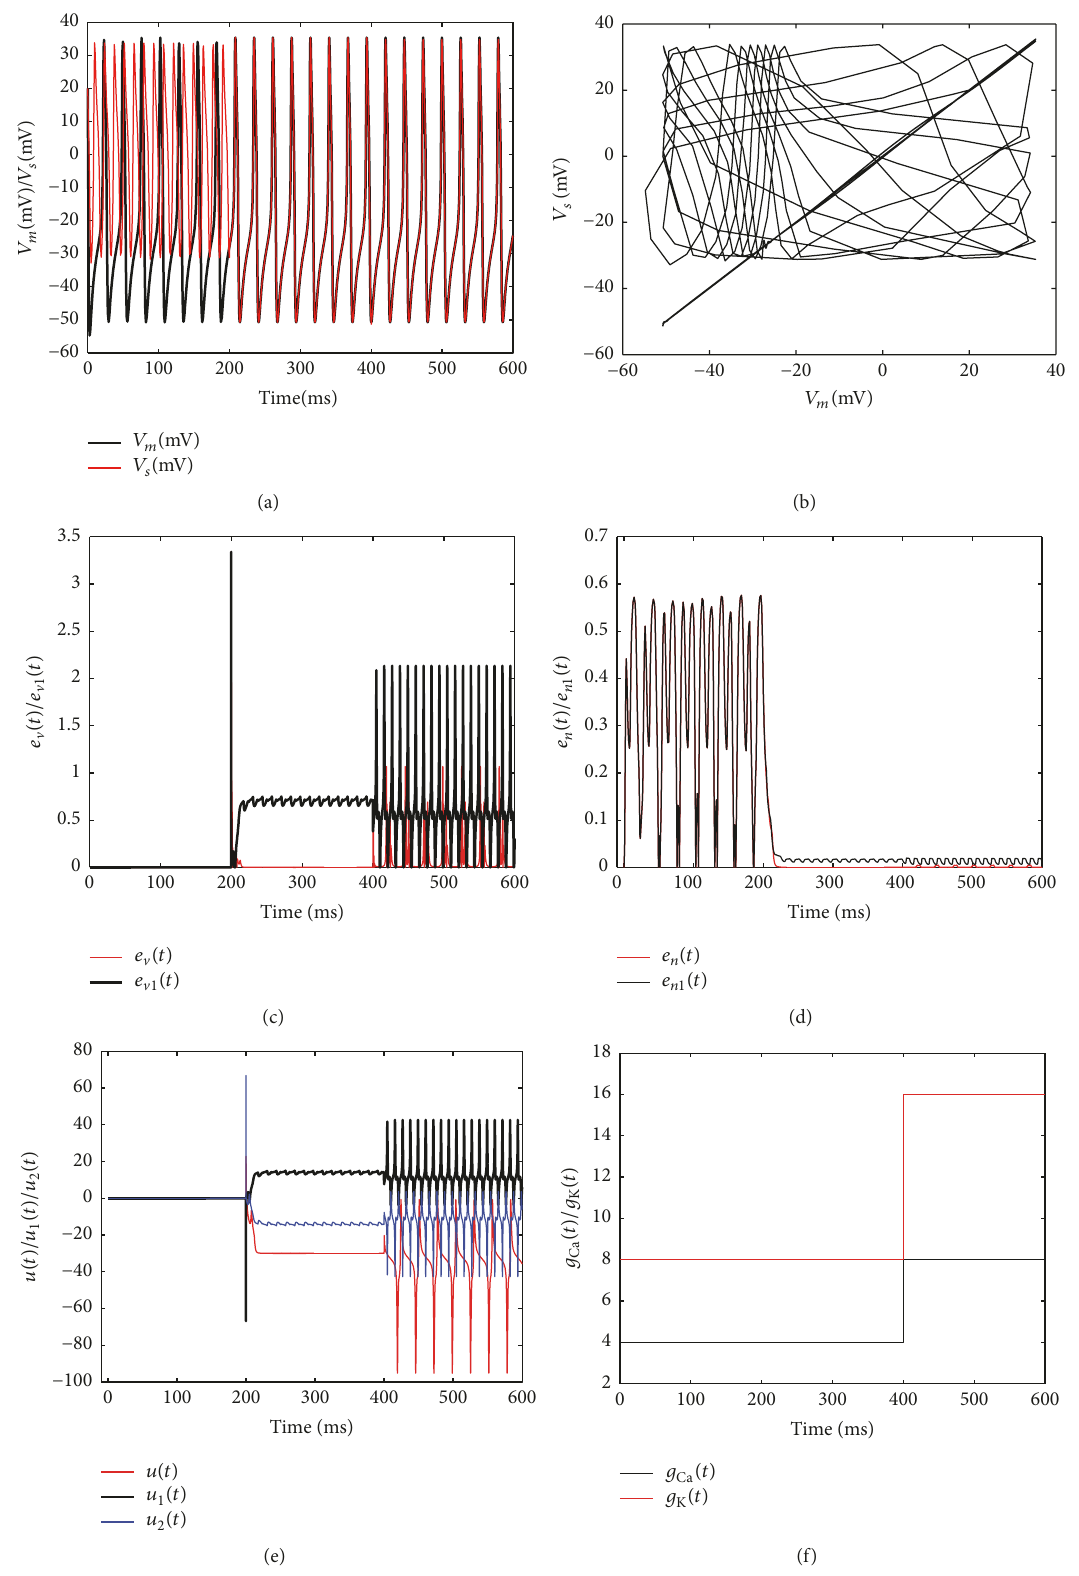
Figure 5: Synchronous response of Morris-Lecar neurons and the comparisons of control inputs (in presence of parameter